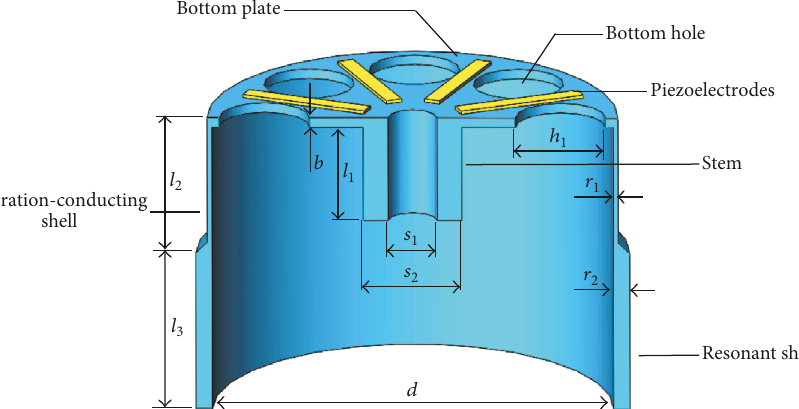
Figure 2: The simulation structure of the resonator.